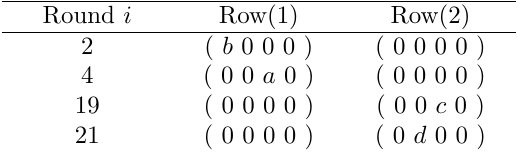
Table 4: The round tweakey differences ∆ tk i used in the key recovery phase. Round i Row(1) Row(2) 2 ( b 0 0 0 ) ( 0 0 0 0 ) 4 ( 0 0 a 0 ) ( 0 0 0 0 ) 19 ( 0 0 0 0 ) ( 0 0 c 0 ) 21 ( 0 0 0 0 ) ( 0 d 0 0